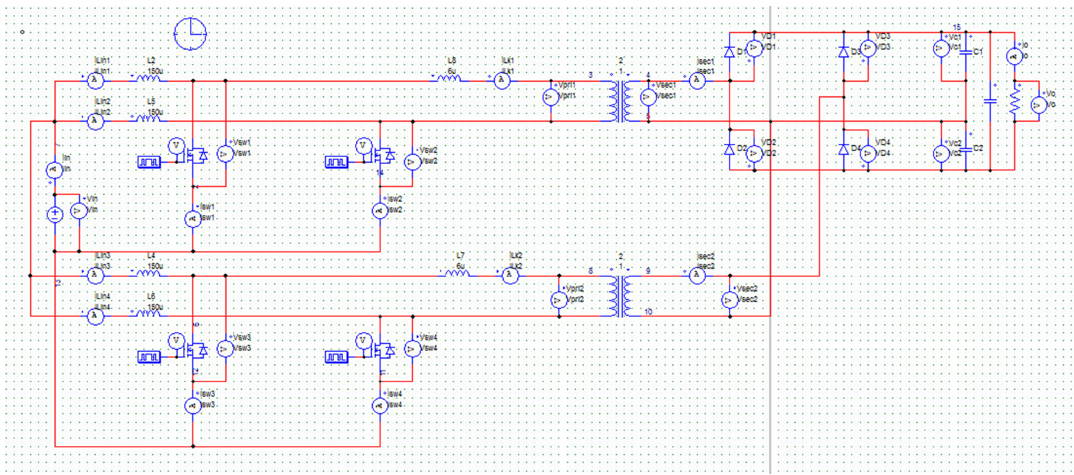
Figure 8. Simulation Circuit in PSIM